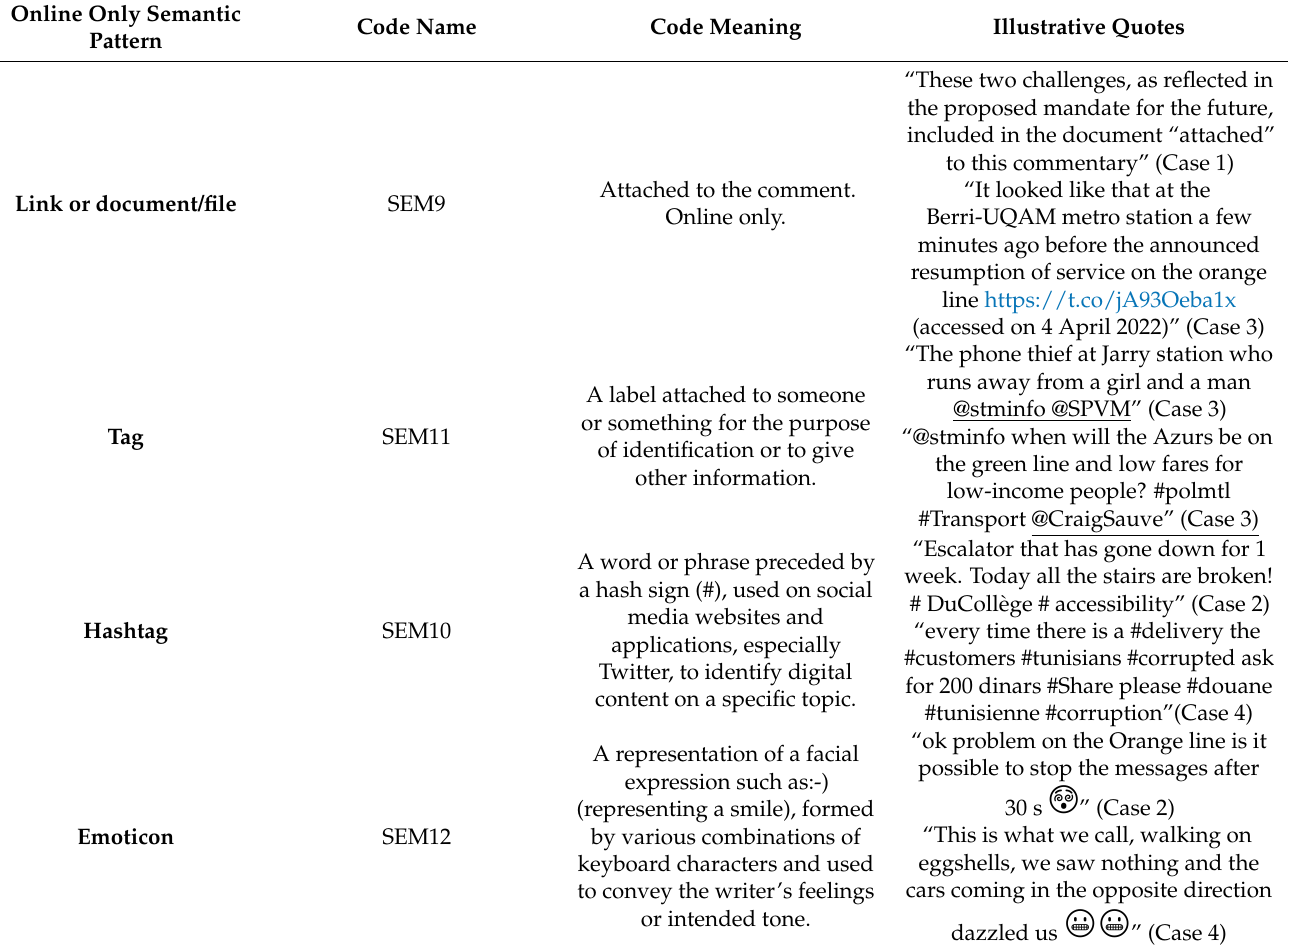
Table A4. Spatial patterns in both online and offline SP data.